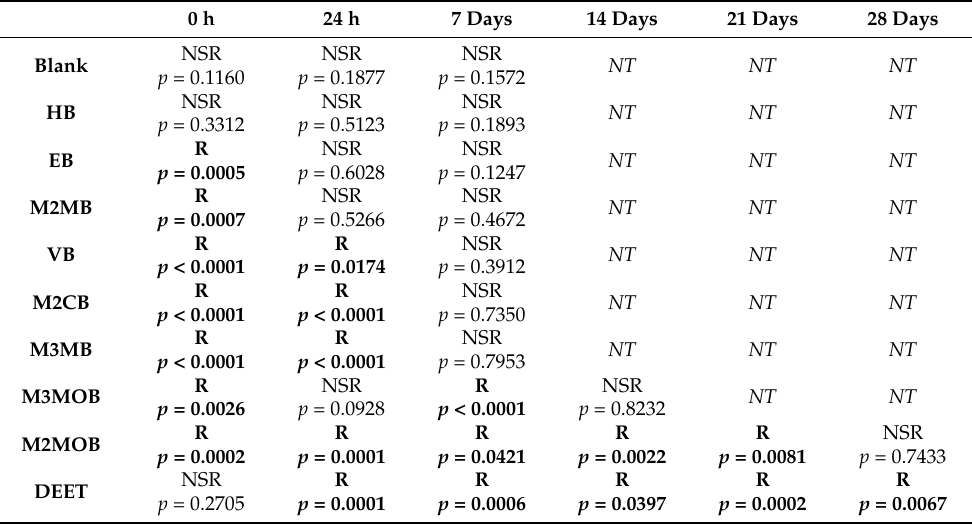
Table 1. Repellency of benzoate compounds over time. If more time was spent, on average, near the untreated filter paper discs, and data were statistically significant ( p < 0.05), the condition is labeled “R” (repellent) and text is in bold. If the time spent near the untreated discs was not significantly greater than the time near the treated disc, the condition is labeled “NSR” (no significant repellency). Repellency label and p value from an unpaired, two-tailed t -test are shown for each compound tested, ranging from immediate testing to seven days for all compounds (0 h, 24 h, 7 days). Additional tests were performed on compounds that showed repellency at 7 days, up to 28 days for M2MOB and DEET. Eight trials ( n = 8) were run for each condition tested, but one subject in the “DEET, zero hour” condition did not enter any of the four zones and was therefore not included in the analysis ( n = 7 for this condition). Conditions not tested are labeled “ NT